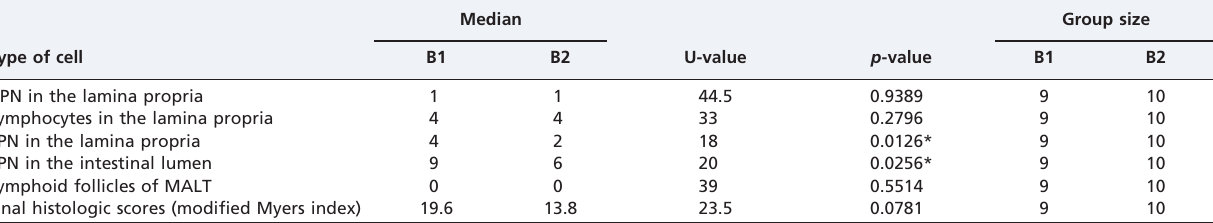
Table 4 - Results of Mann-Whitney U test for comparisons between types of inflammatory cells along with the role of lymphoid follicles in the control group (B1) and group treated with short chain fatty acids (SCFAs) (B2).